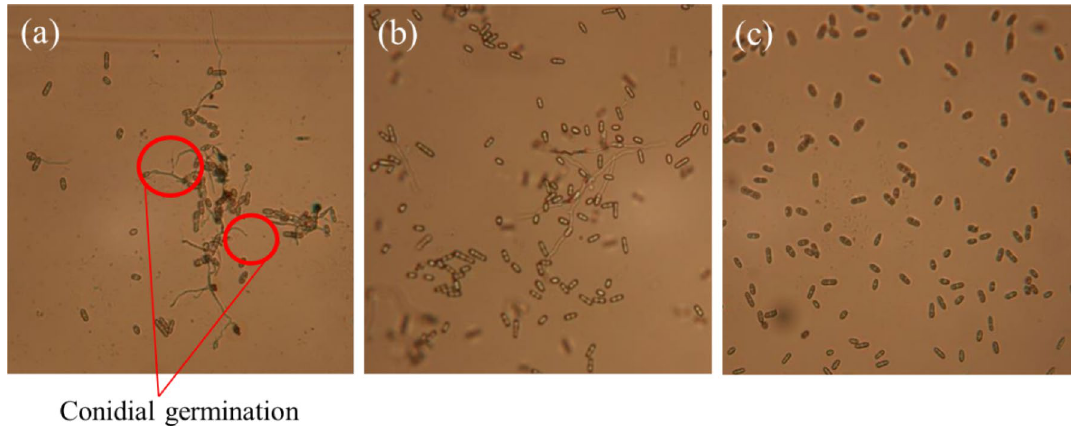
Figure 9. The photos of an amount of conidial suspension under the microscope at different UVC doses at ( a ) control, ( b ) 0.18, and ( c ) 1.08 kJ/m 2